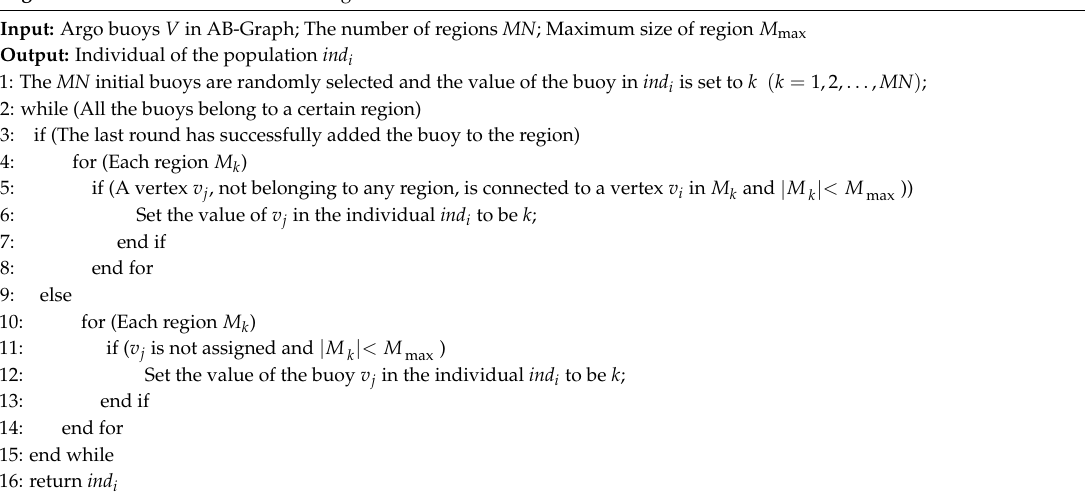
Algorithm 1 : Individual initialization algorithm